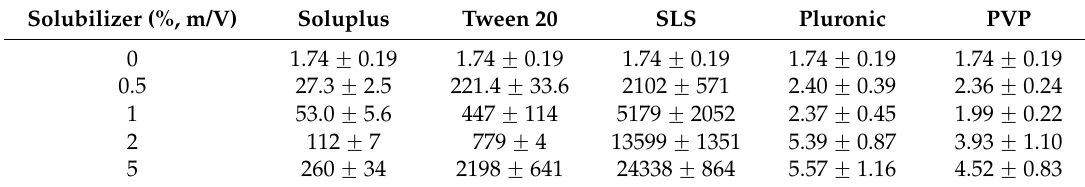
Table 1. Solubility of simvastatin (SVS, µ g/mL ˘ sd.) in water in combination with different amounts (%, m/V) of solubilizers Soluplus, Tween 20, sodium lauryl sulfate (SLS), Pluronic, and Polyvinylpyrrolidone